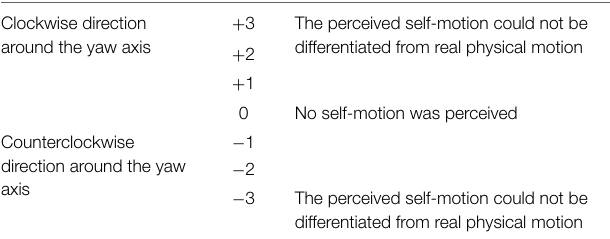
The bottom-right number in each cell is the detailed trial number for each experimental condition.